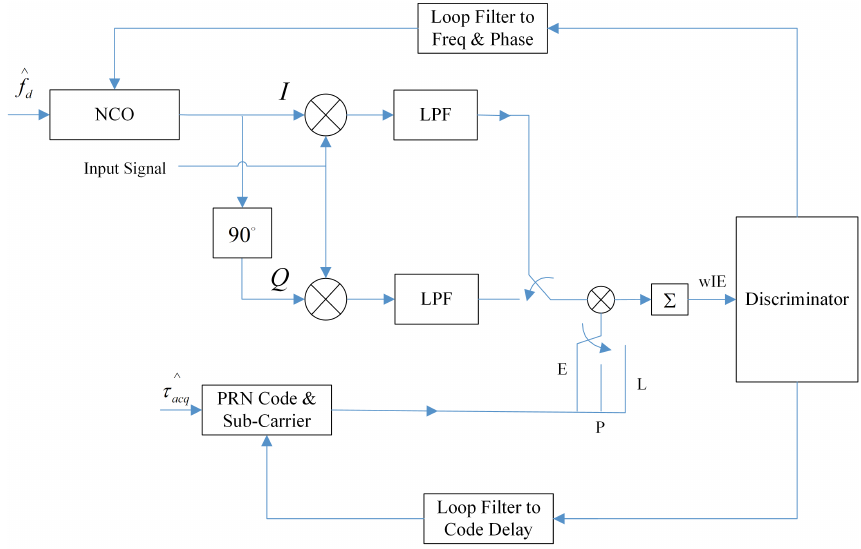
Figure 7. Block diagram of tracking